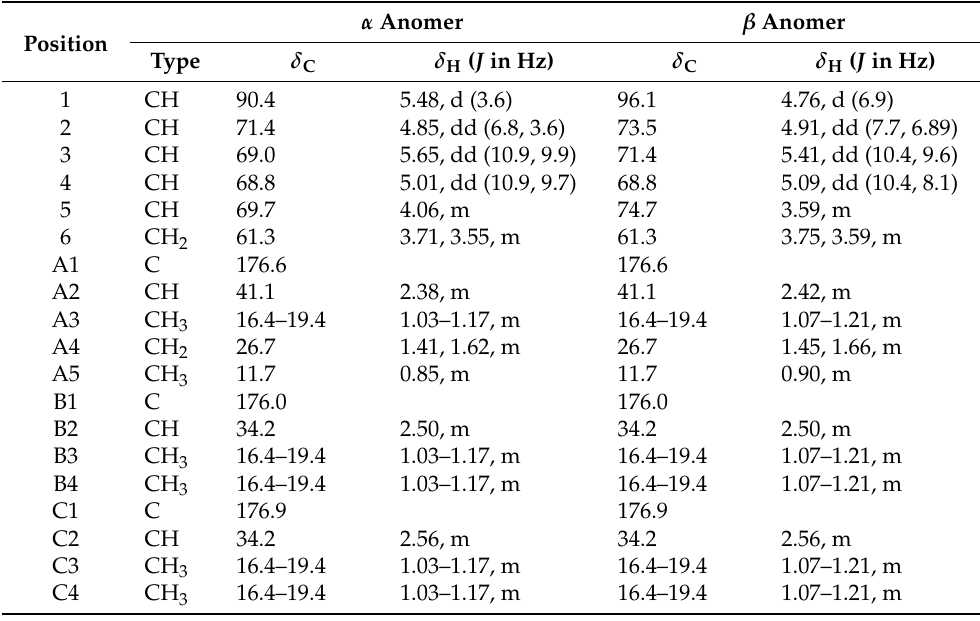
Table 2. 1 H NMR (500 MHz) and 13 C NMR (126 MHz) spectroscopic data of natural pennelliiside